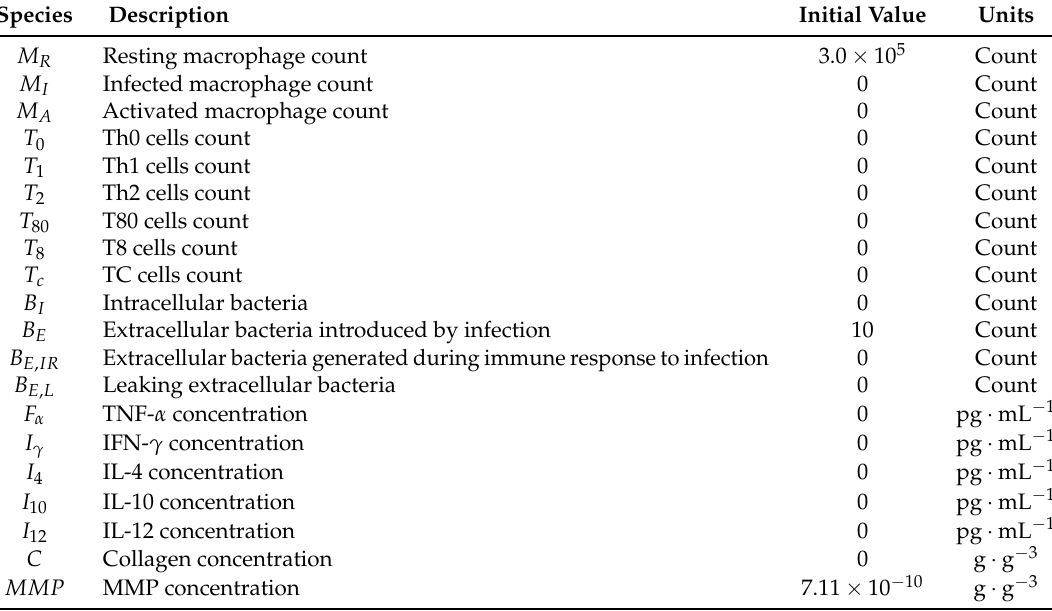
Table 2. Initial conditions for each species in the combined immune response and TB granuloma activation model (TNF: tumor necrosis factor; IFN: interferon; IL: